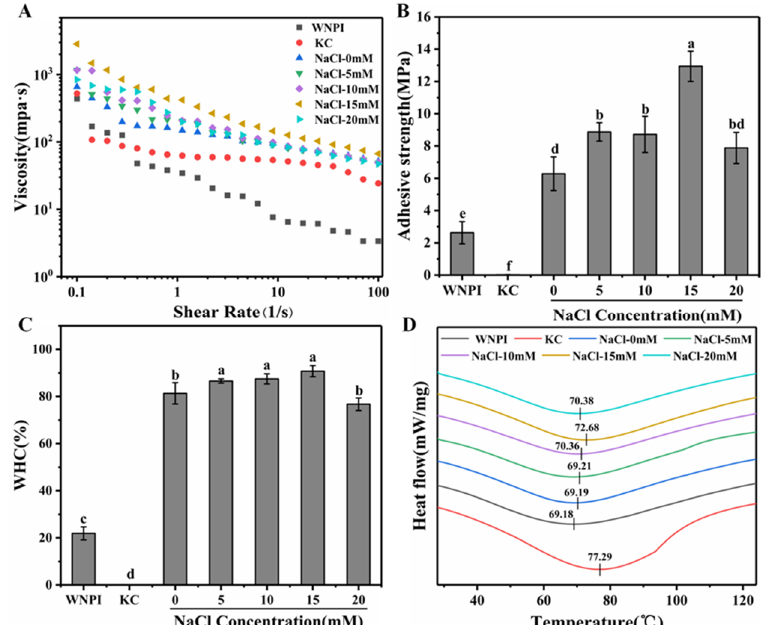
Figure 2. Apparent viscosity ( A ), Adhesive strength, ( B ) WHC ( C ), and DSC ( D ) of WNPI-KC composite gel samples with NaCl. Different letters on the bars indicate significant differences ( p < 0.05).